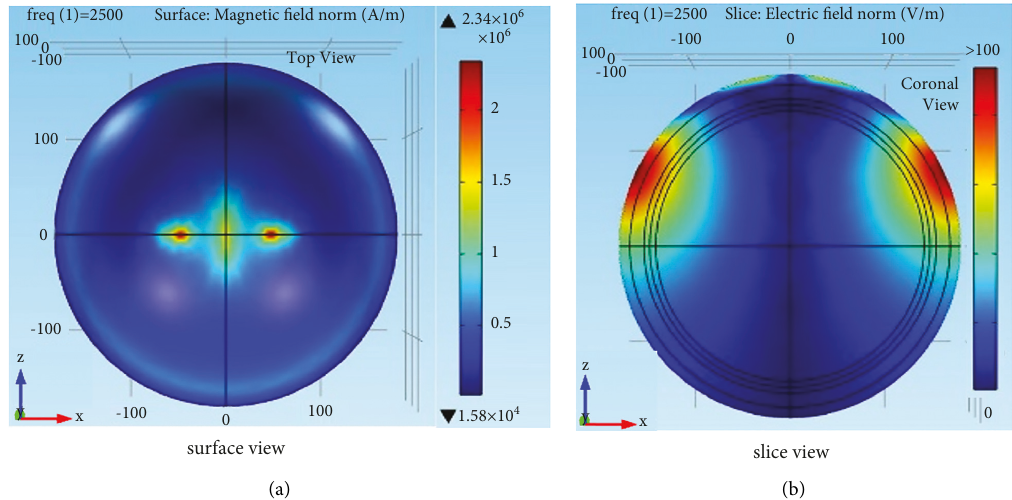
Figure 8: (a) Magnetic field and (b) electric field distribution of the HVA coil with C-type thin core.